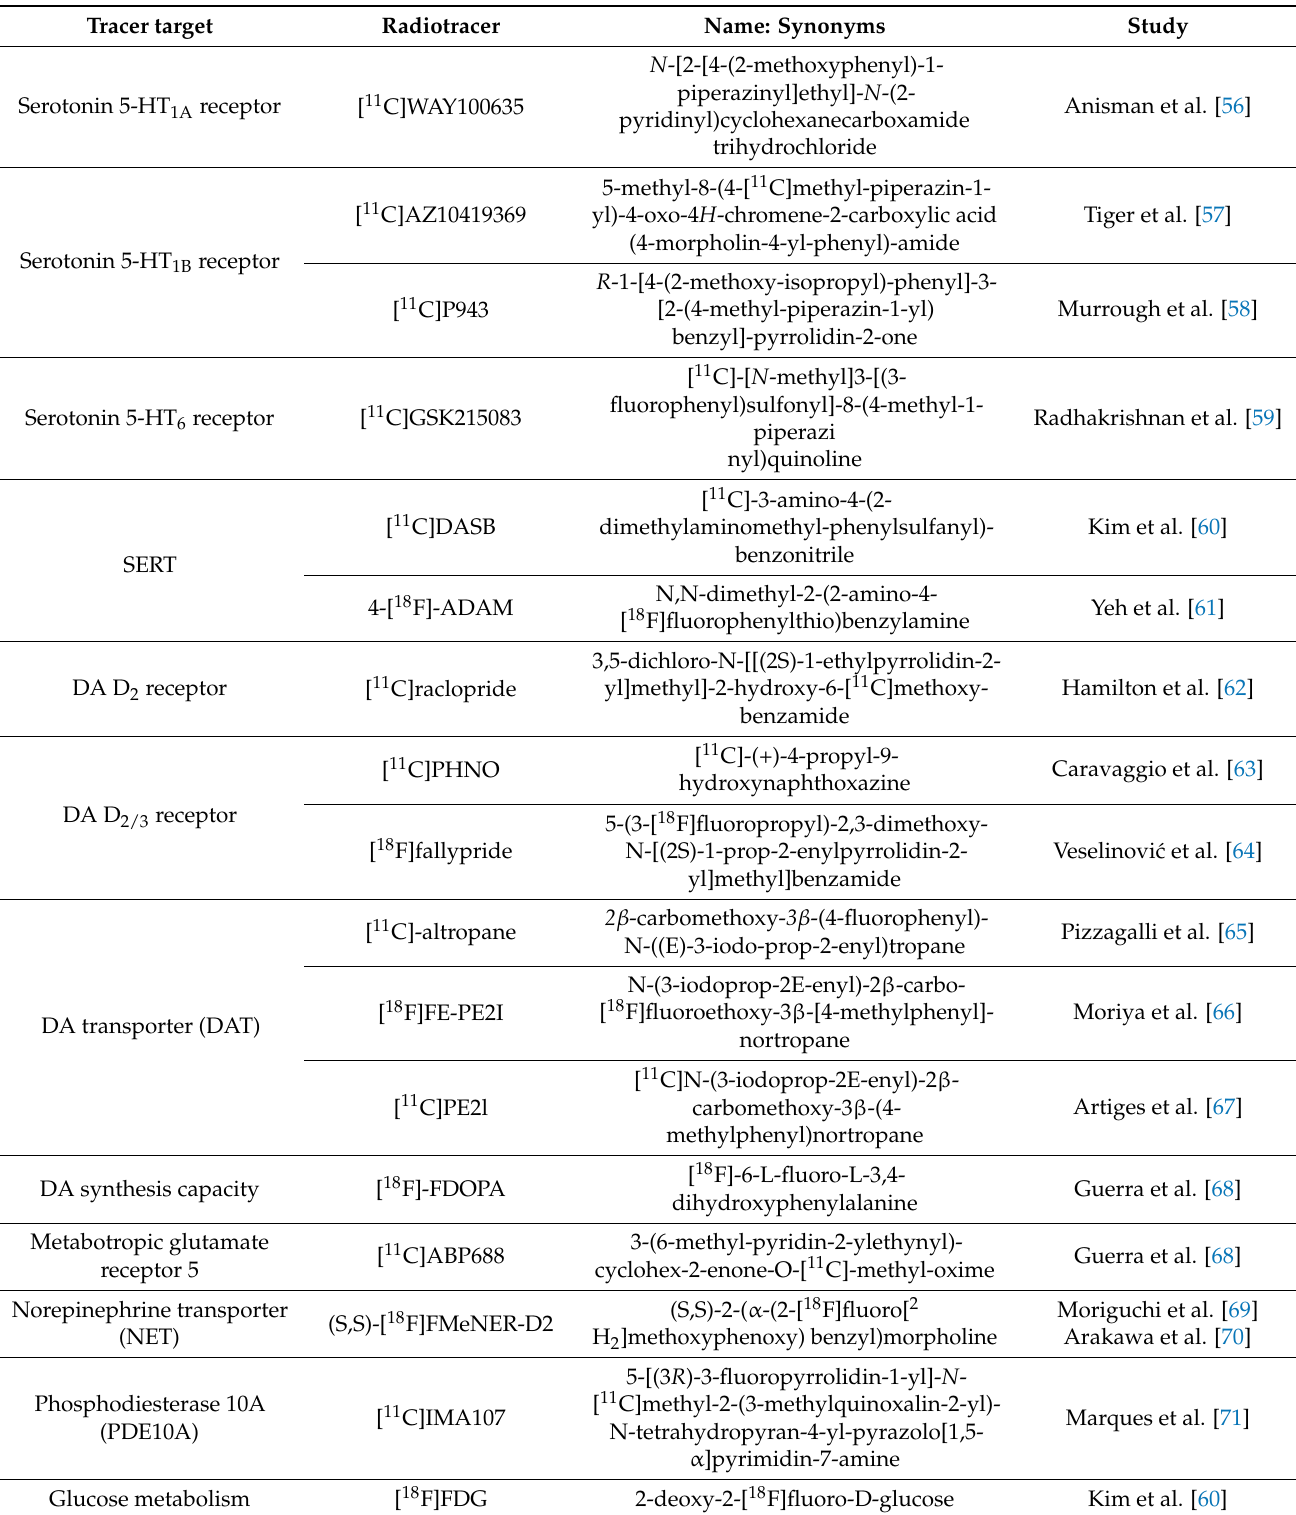
Table 1. Tracer targets and radiotracers reviewed in Sections 3 and